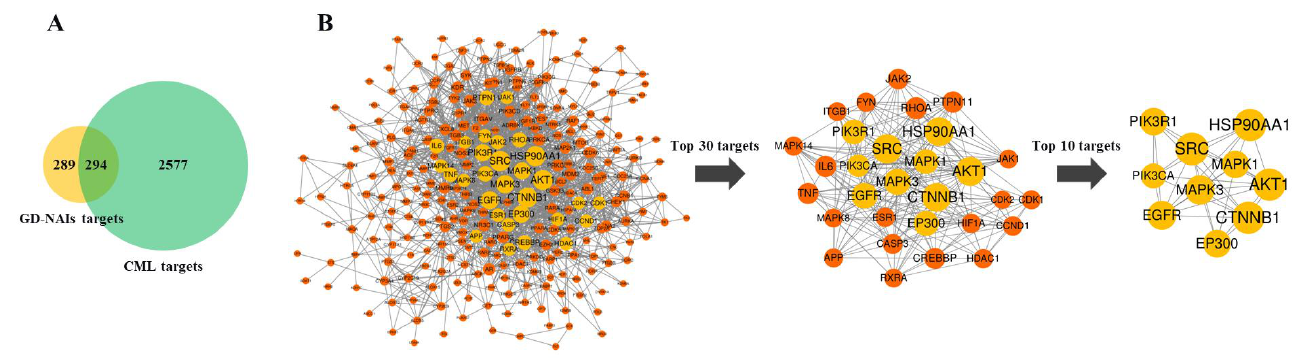
PIK3R1, MAPK1 and PIK3CA were screened out (Figure 4B). These targets might be the key targets of GD-NAIs against CML.